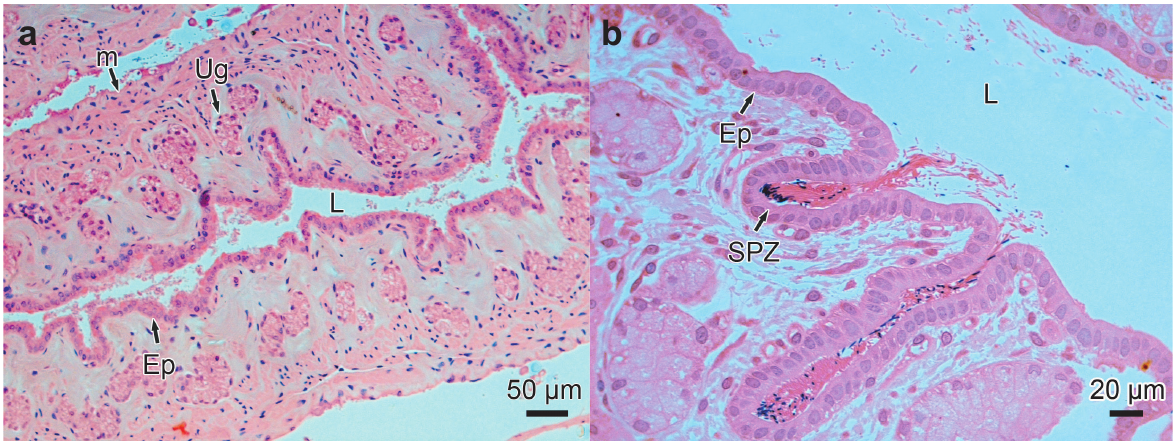
Figure 4. Histology of the uterus (a) and UVJ (utero-vaginal junction b) of Thamnodynastes strigatus from South Brazil. Transverse section of the uterus during the reproductive season (a) and UVJ in autumn exhibiting sperm storage in furrows (b). Ep, epithelium m, muscular layer L, lumen SPZ, spermatozoa Ug, uterine glands. Light microscopy of samples stained with